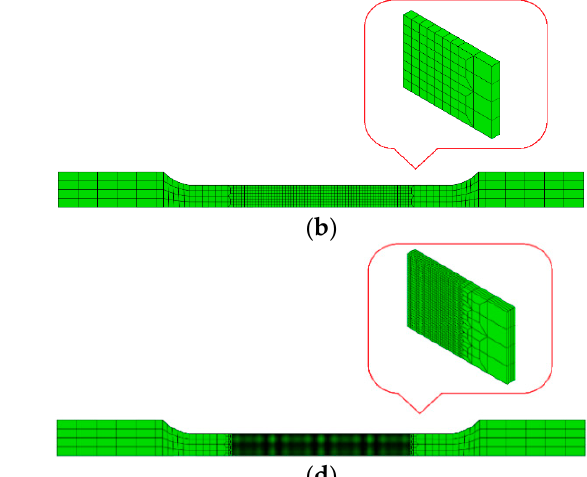
dicted results obtained with the full set parameters of the GTN damage model for the CR980XG3 TM steel.